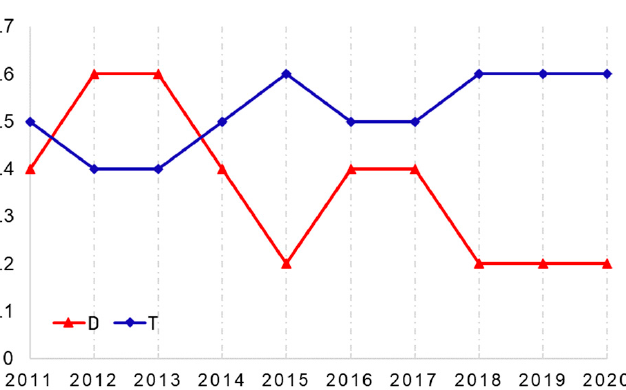
Figure 7. Graph with best fit D and T values plotted for the years 2011–2020.